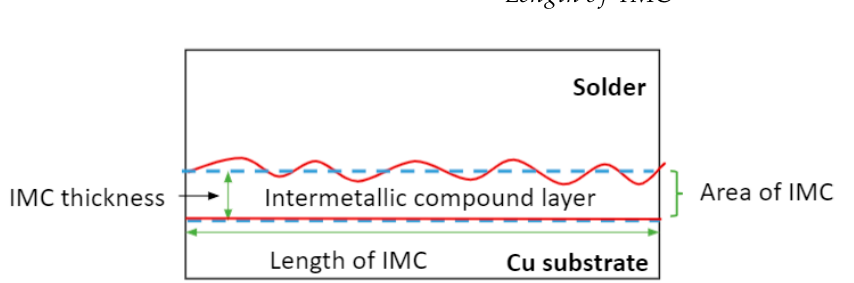
Figure 2. The calculation of the IMC’s thickness.